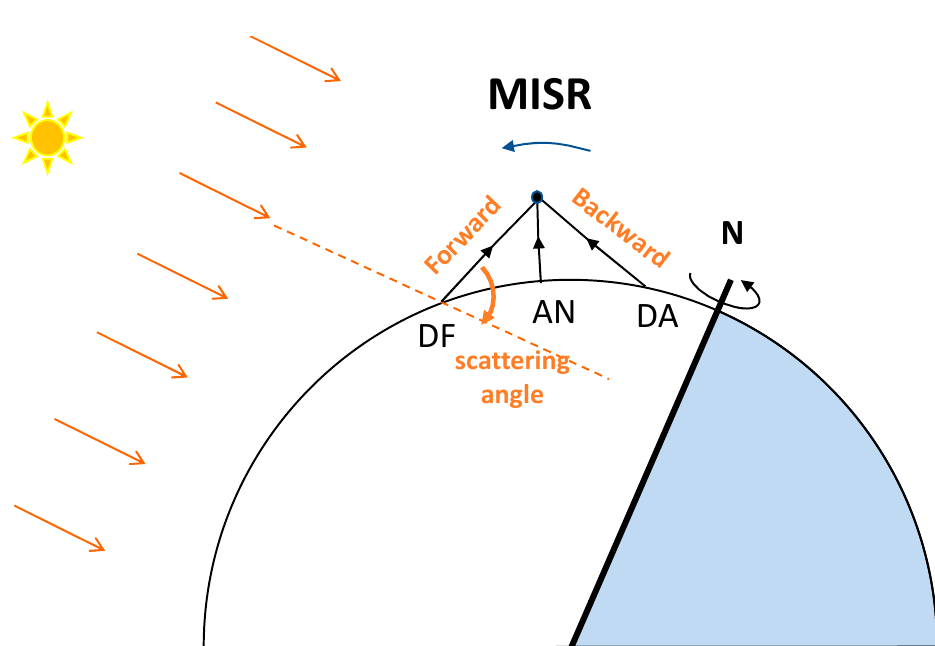
Figure 1. MISR viewing geometry at the NH high latitudes where the DF and DA views (70.5 ◦ from nadir) have relatively large forward and backward scattering